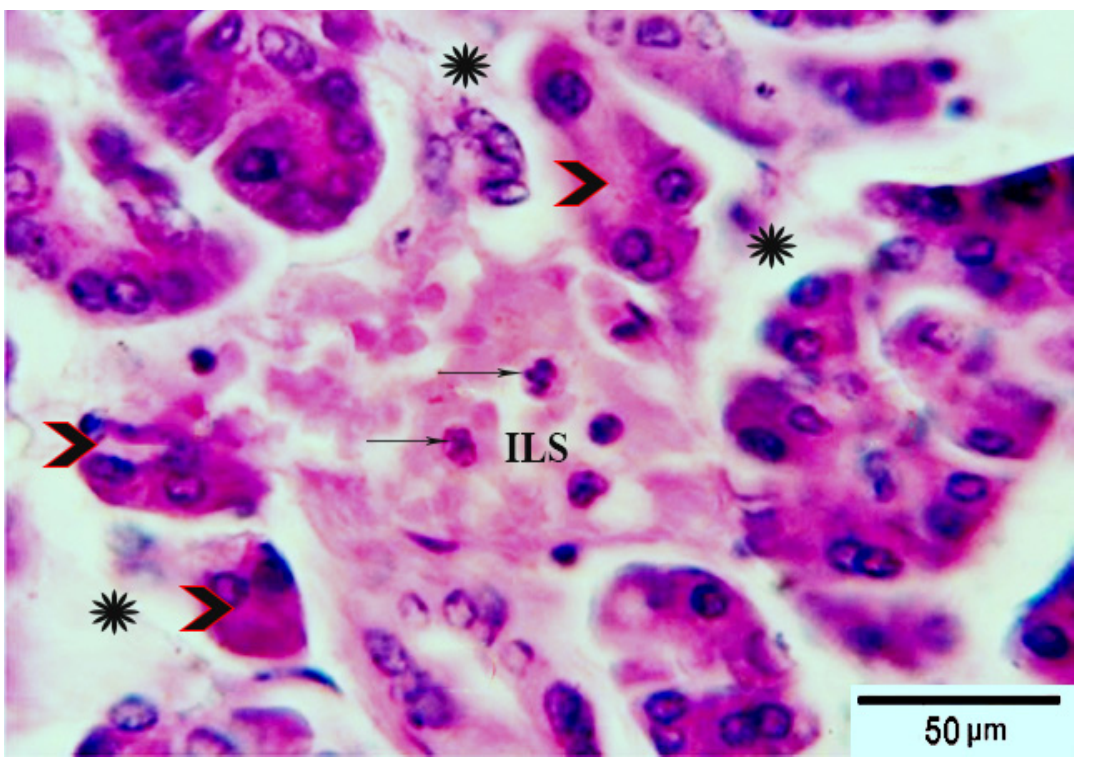
Figure 1. Photomicrograph of pancreatic tissue sections from control group 1 rats showing: well defined normal large pale islets of Langerhans (ILs) with normal cellular shape and density (arrows) Figure 2. Photomicrograph of pancreatic tissue sections from group 2 rats showing: pale distorted islets of Langerhans (ILs) in between the acidophilic pancreatic acini (arrowheads), separated by edema (stars). The acinar cells had vacuolar degeneration and dissociation (arrowheads) and the islets Fermentation 2022 , 8 , x FOR PEER REVIEW showing depletion of its constituent cells (arrows). H&E stain. The bar size is indicated under picture.